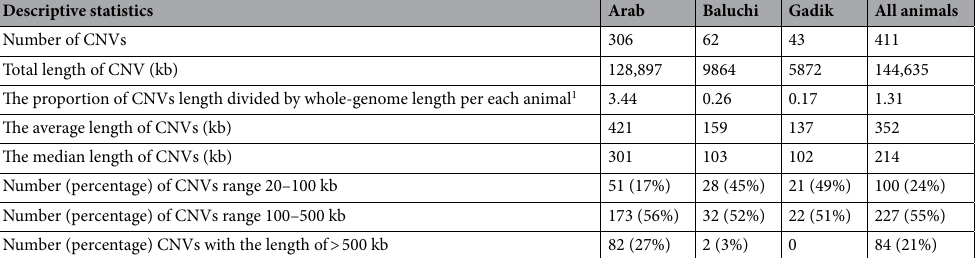
Table 1. Summary of CNVs identified in Afghan sheep breeds. 1 The length of the sheep genome is considered to be 2500,000 kb (https:// www. ensem ble.